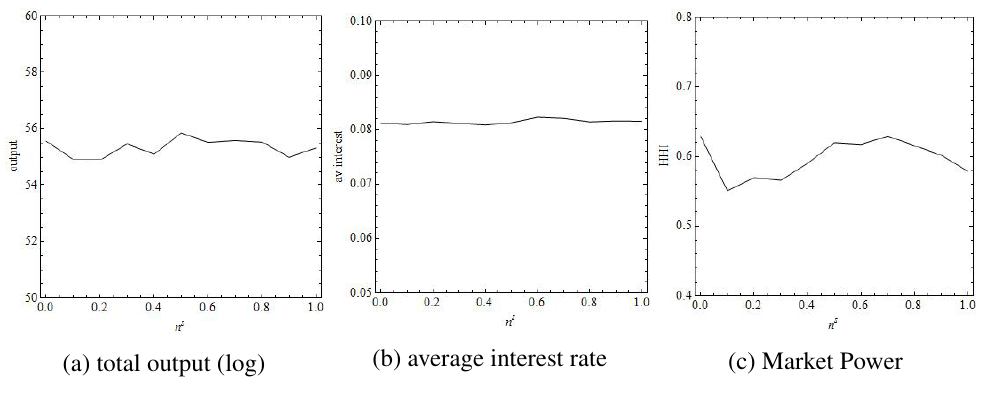
Figure 5: Impact of bargaining power